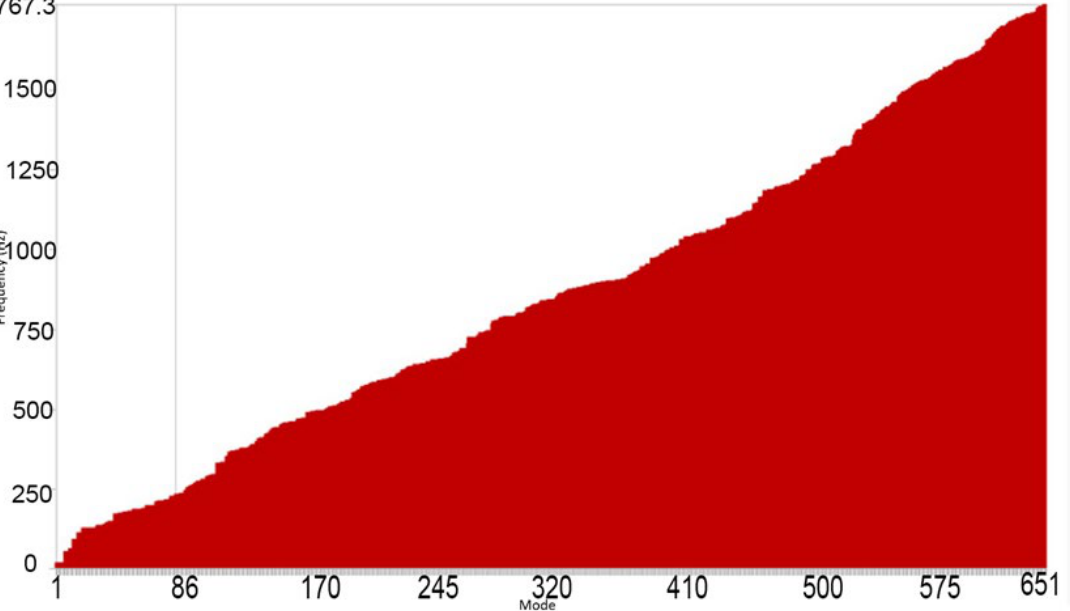
Figure 16. Mode ( X -axis) v/s frequency. Each mode has a respective frequency for analysis.